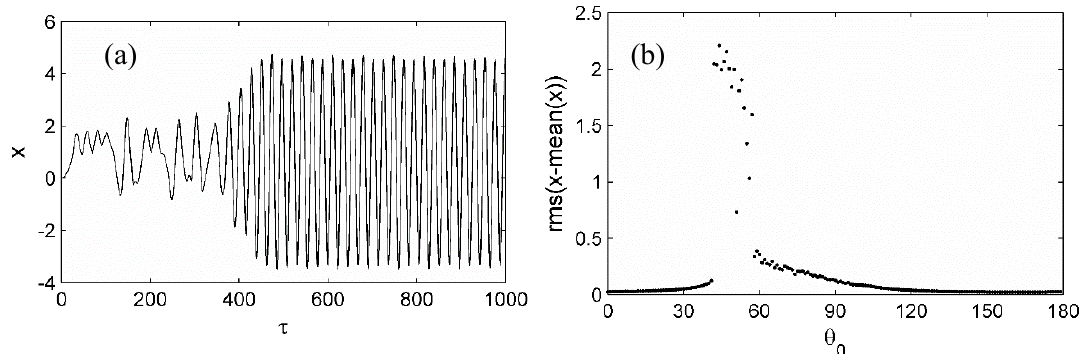
Figure 7. Amplitude of oscillation from the zero initial position at µ o = 0.5, ( a ) time signal at θ o = 49 ◦ , and ( b ) root mean square of x-displacement.